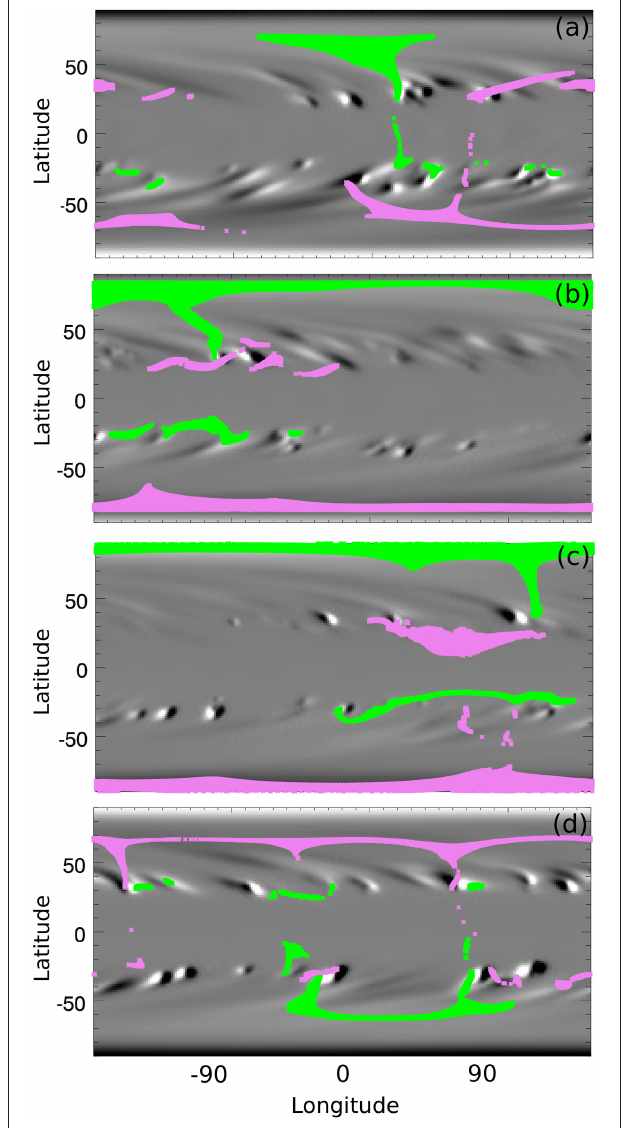
FIGURE 8 | Maps of the source regions of coronal holes at the surface. The color scheme and the instants represented are the same as in Figure 7 . produce long polarity inversion lines that last long enough to sustain loop arcade systems that extend above them (e.g., in the two last panels, on the northern hemisphere, left side of the image). Overall, there seems to be a rather large fraction of closed to open magnetic flux between the solar surface and the source- surface, with open flux regions being rooted on small portions of the surface. This is more easily visible in Figure 8 , which shows maps of the regions of the surface that are magnetically connected to the coronal holes that form above them. The color scheme is the same as in Figure 7 . In comparison to the real Sun, the total extent of sources of open field is small, especially the polar regions at solar minimum. In fact, the emerging regions hold very intense and concentrated magnetic fluxes. Figure 9 shows the variation of the total unsigned open magnetic flux